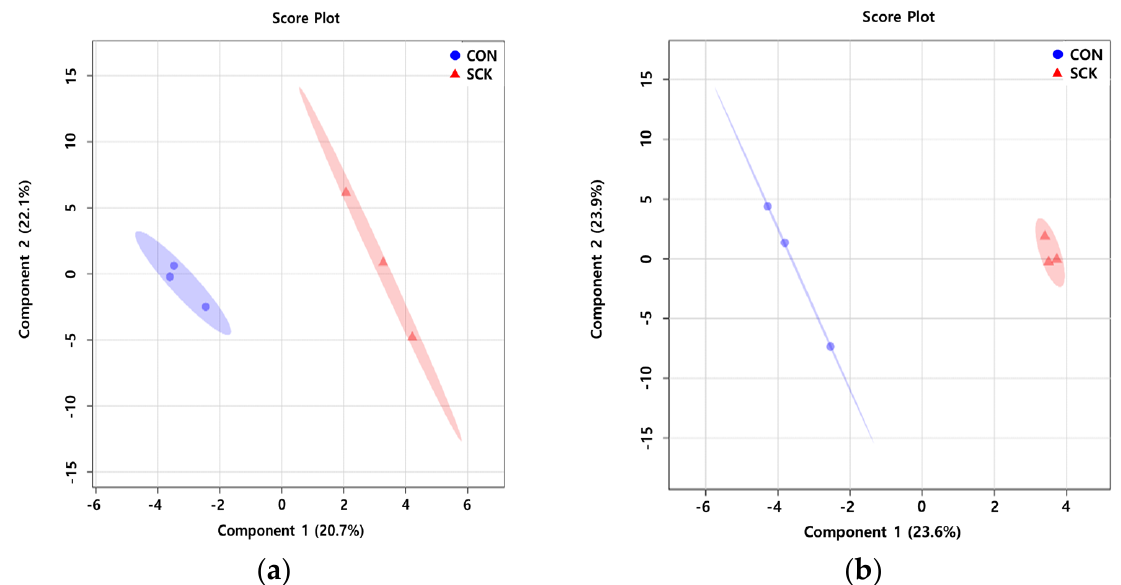
Figure 2. Partial least square-discriminant analysis score plot of rumen fluid ( a ) and milk ( b ) with healthy (CON) and subclinical ketosis (SCK) groups by proton nuclear magnetic resonance analysis ( n = 3). The shaded ellipses represent the 95% confidence interval estimated from the score. On the score plot, each represents an individual sample, with the blue circle representing the CON, and the red triangle representing the SCK group. The abscissa and ordinate represent the variance associated with component 1 and 2, respectively.